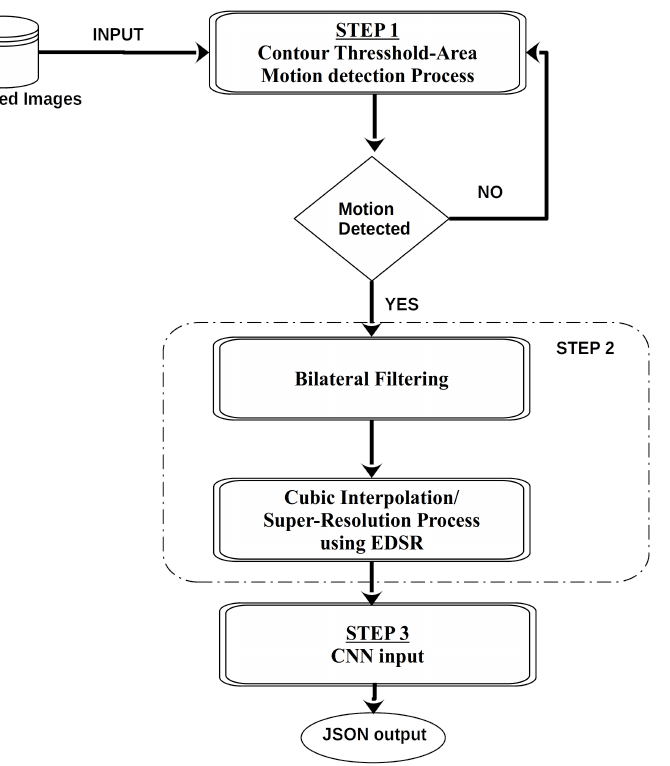
Figure 3. Bee swarming service automated detection process. Step 1 is the threshold max-contour image selection process issued only by Version 2 devices as part of the sequential frames’ motion detection process instantiated periodically. Upon motion detection, photo frames that include the activity notifi- cation contours for Version 2 devices or uploaded frames from Version 1 devices are transformed through a bilateral filtering transformation with sigma_space and sigma_color parameters equal to 0.75 and a pixel neighborhood of 5 px. Upon bilat- eral filter smoothing, the scaling process initiates to normalize images to the input dimensions of the CNN. For down-scaling or minimum dimension up-scaling (up to 100 px), cubic interpolation is used, while for large up-scales, the OpenCV super- resolution process is instantiated (Enhanced Deep Residual Networks for Single Image Super-Resolution) [52] using the end node device. Upon CNN image nor- malization, the photos are fed to the convolutional neural network classifier, which detects the number of bee contours and reports it using XML output image reports, as presented